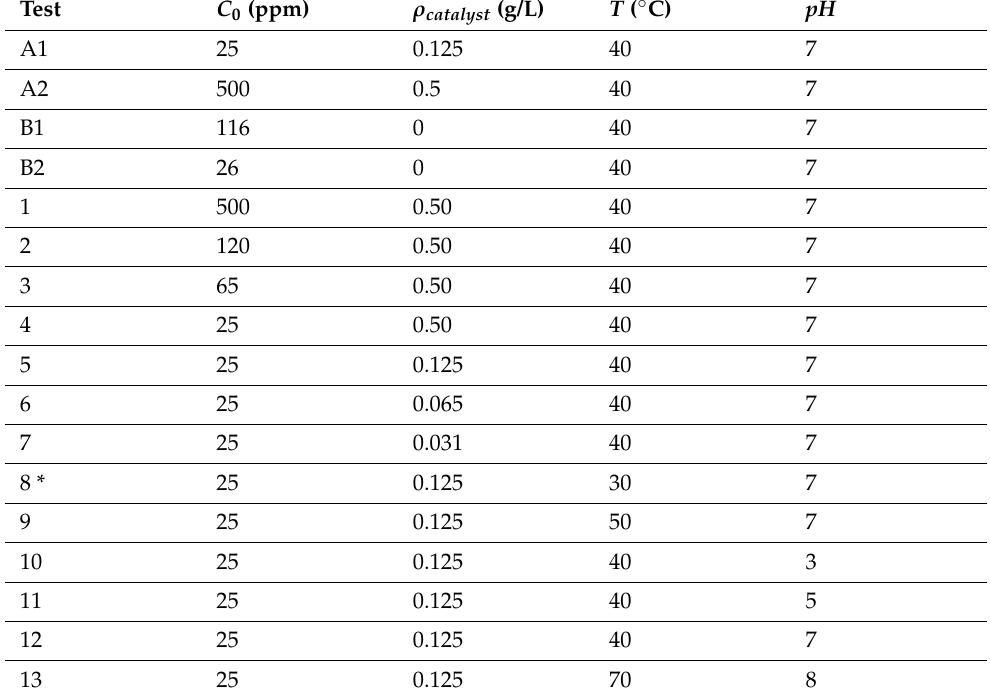
Table 2. Experimental conditions for each kinetic experiment conducted in the batch reactor. C 0 : initial phenol concentration (ppm), ρ catalyst : loading (g/L), T : temperature ( ◦ C). * Experiment repeated to investigate the reusability of the